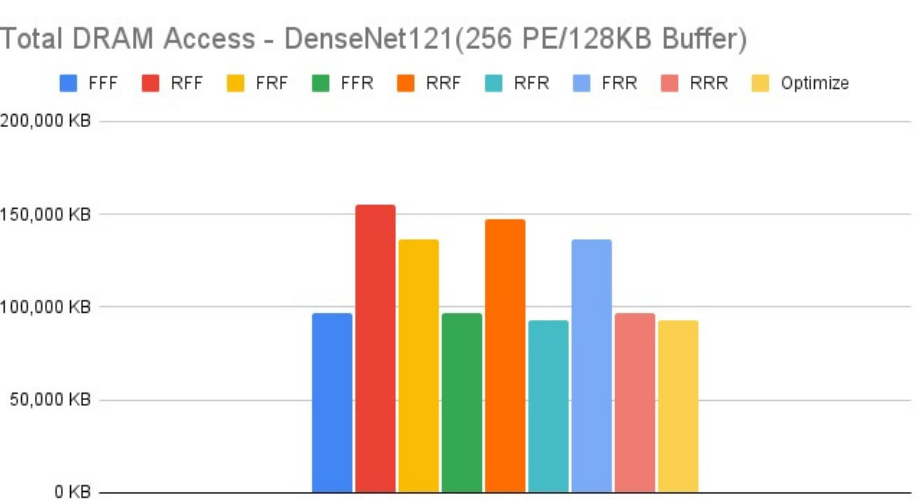
Figure 14. Total DRAM access—HarDNet39 (1024 PE/128 KB Buffer).